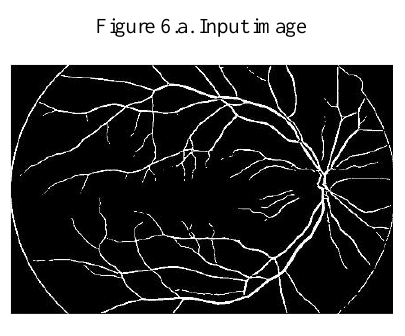
Figure 6.b. Output image